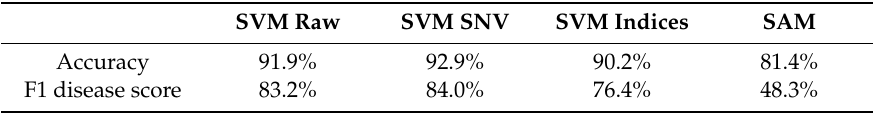
Table 1. Comparison of evaluation parameters obtained on test data for di ff erent data representations and prediction algorithms on the ground scale for the support vector machine (SVM) and the spectral angle mapper